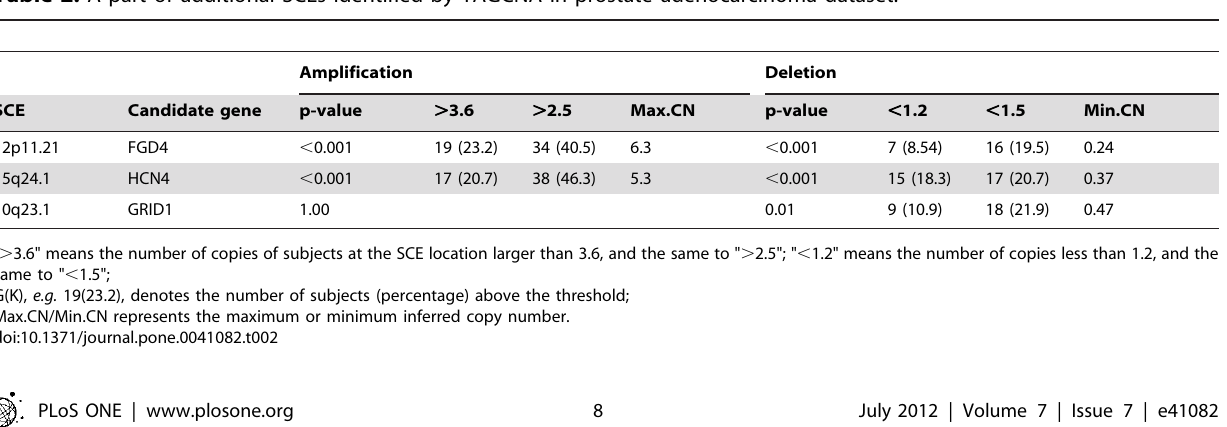
Table 2. A part of additional SCEs identified by TAGCNA in prostate adenocarcinoma